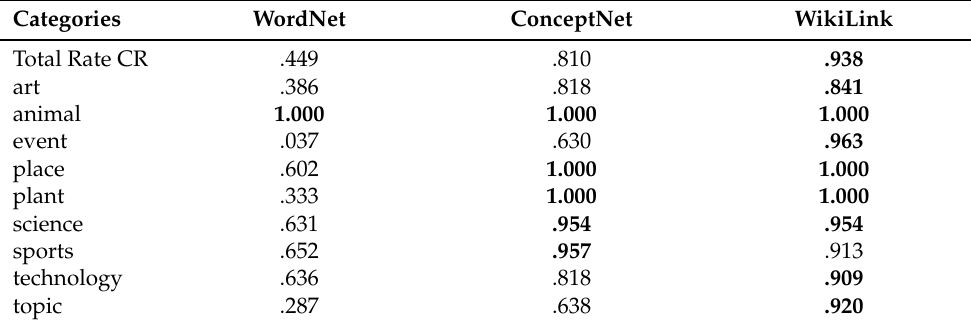
Table 2. Retrieving results of golden